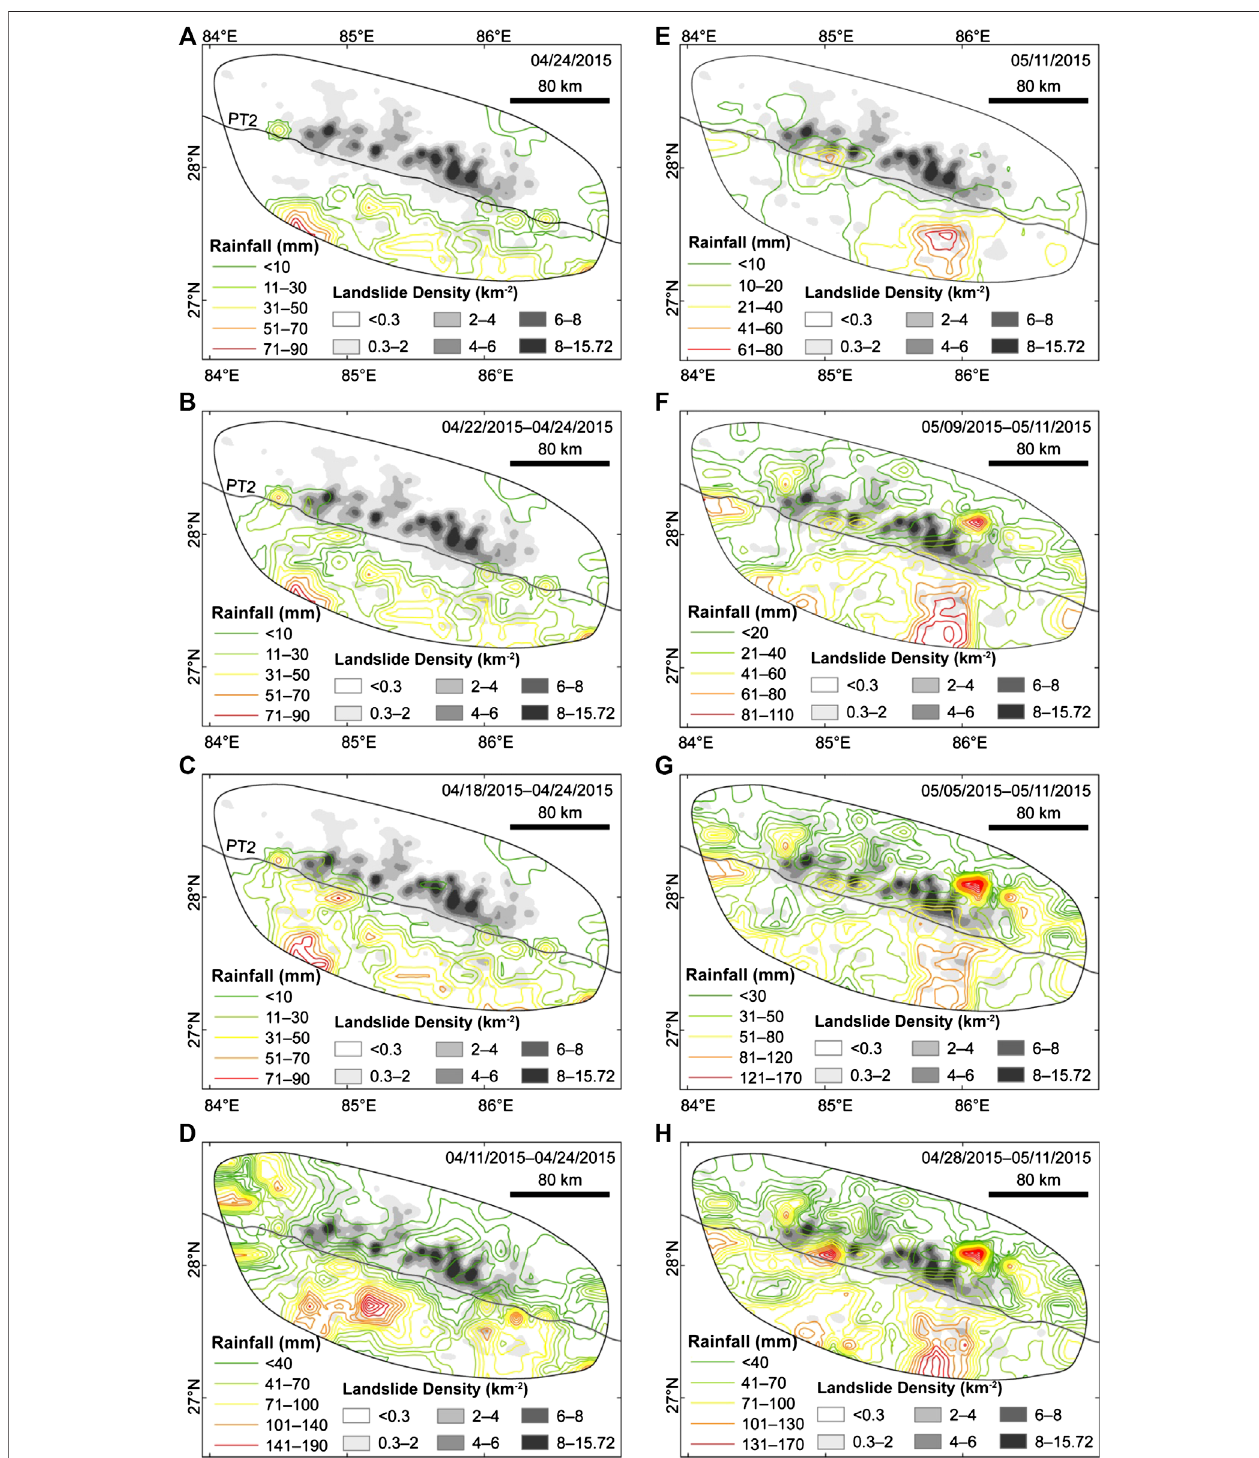
FIGURE 8 | Landslide density vs. antecedent accumulative precipitations (mm) of 1 day, 3 days, 1 week, and 2 weeks before the April 25 mainshock (A – D) and 1 day, 3 days, 1 week, and 2 weeks before the May 12 aftershock (E – H) . PT2: physiographic transition.